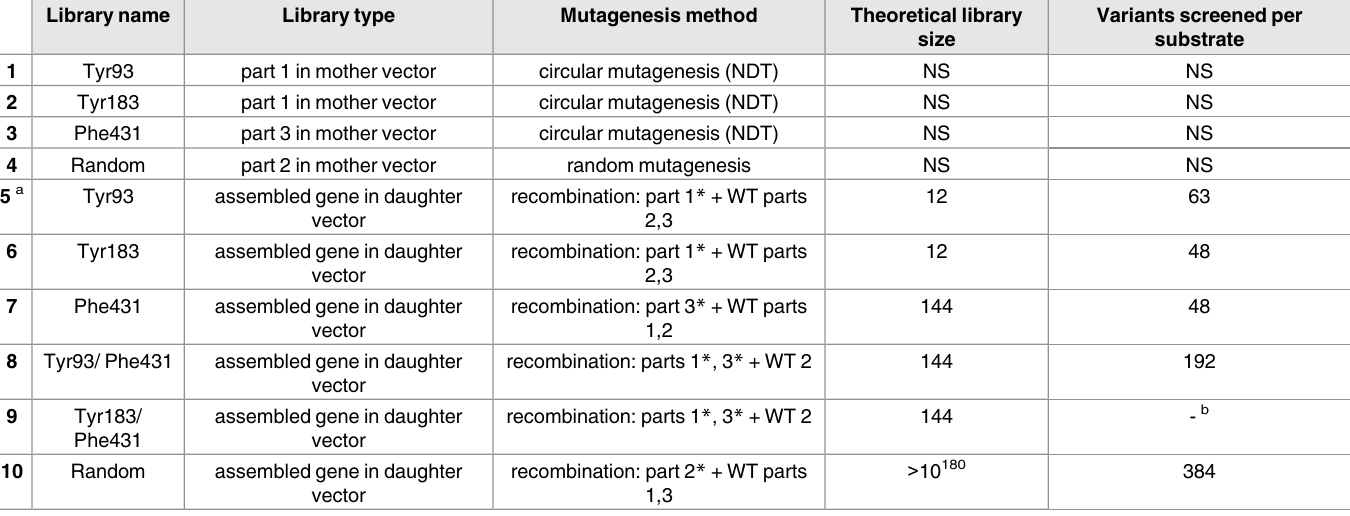
Table 1. Mutated Cal-A libraries generated.